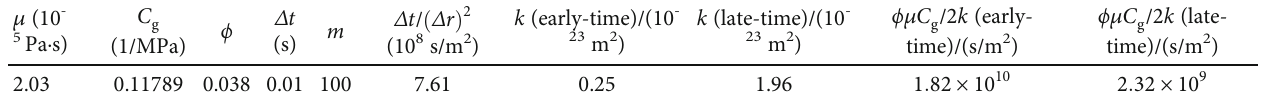
Figure 4: Curve fi tting with (a) late-time and (b) early-time analytical methods at 8.117MPa and 303.15K. F particle, and F is the cumulative gas uptake [11]. U Table 2: Stability analysis of numerical model based on Sample 3 at 8.177MPa and 303.15K